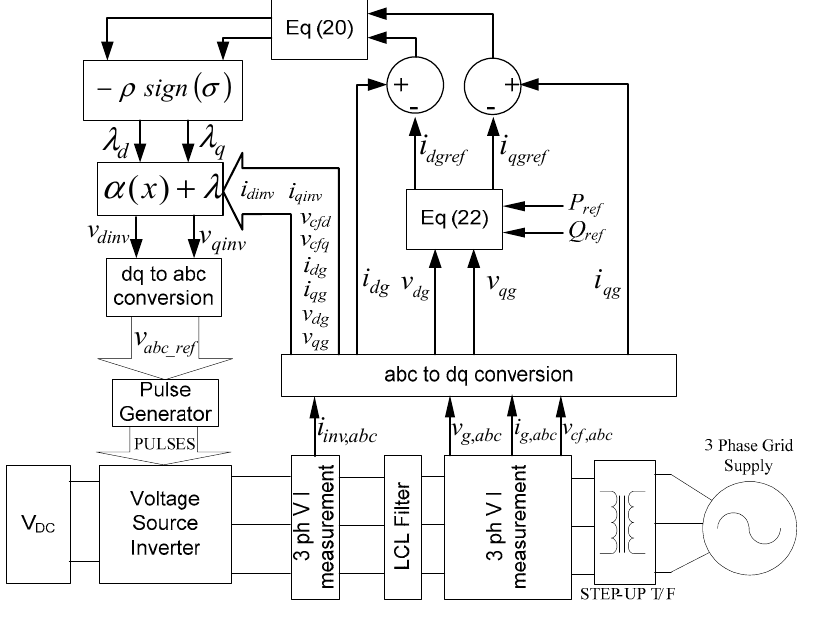
Figure 5. Control block diagram of SMC controller for VSI.